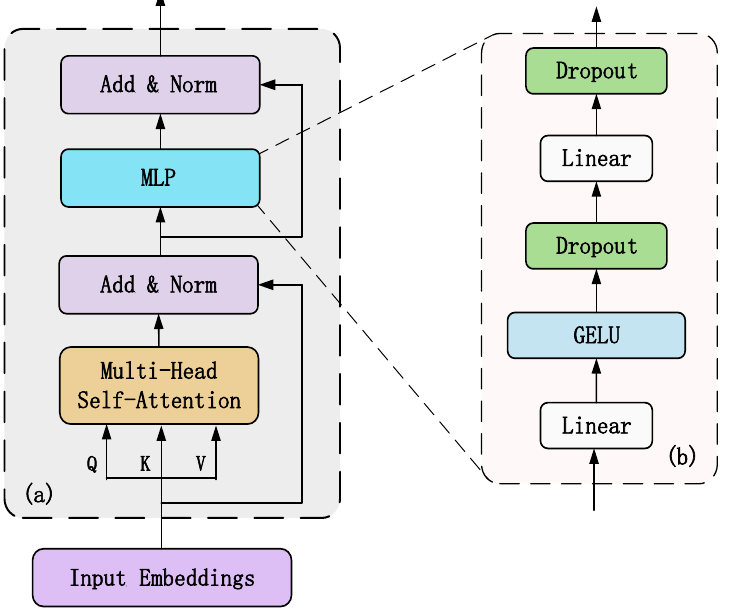
Figure 5. The architecture of the transformer encoder module. ( a ) the architecture of the transformer encoder module, ( b ) the internal architecture of the MLP.